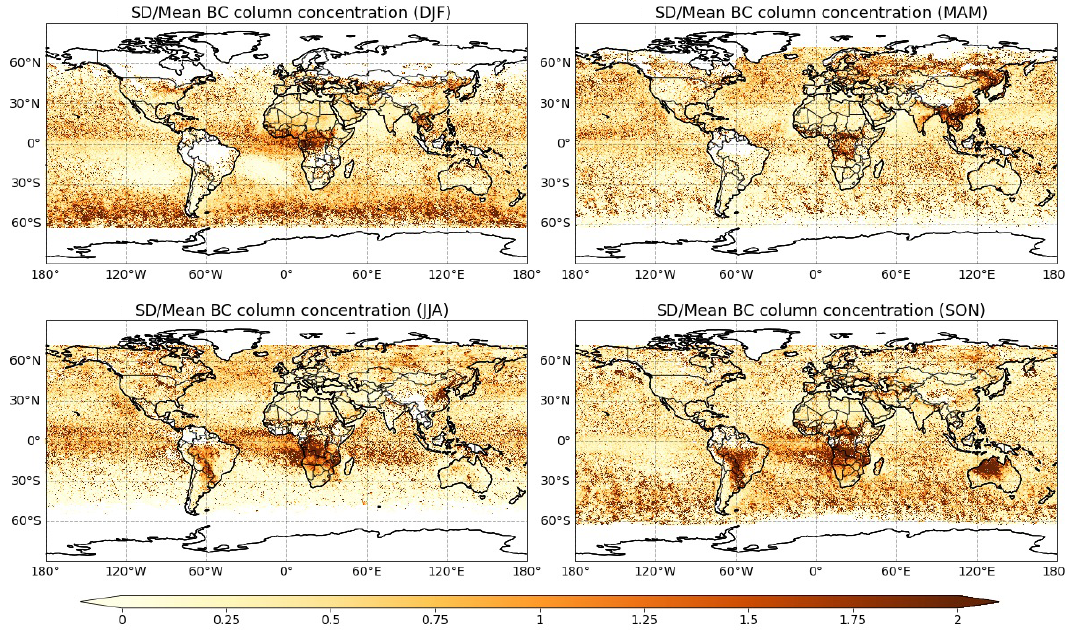
Figure 2. The standard deviation (SD)/mean for seasonal BC column mass concentration in Fig. 1 derived from POLDER-3